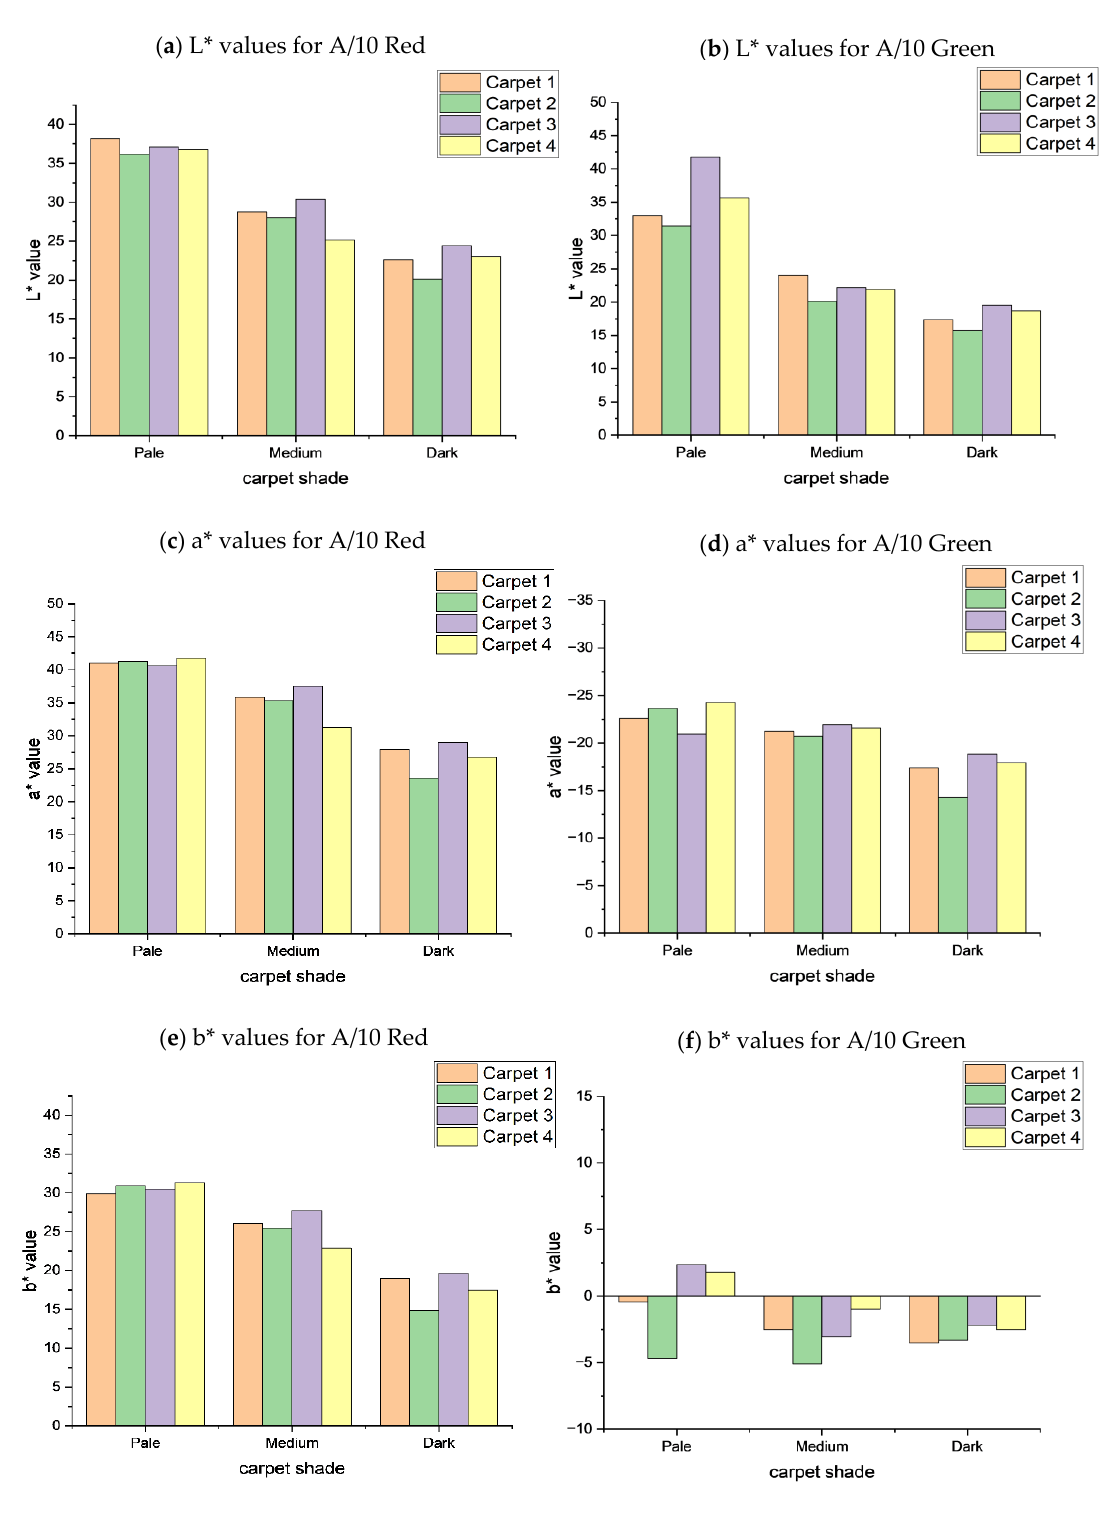
Figure 5. CIE L*, a*, and b* values for A/10 illumination of different carpets dyed in different shades of red and green color ( a ) L* values for red-colored carpets ( b ) L* values for green-colored carpets ( c ) a* values for red-colored carpets ( d ) a* values for green-colored carpets ( e ) b* values for red-colored carpets ( f ) b* values for green-colored carpets.